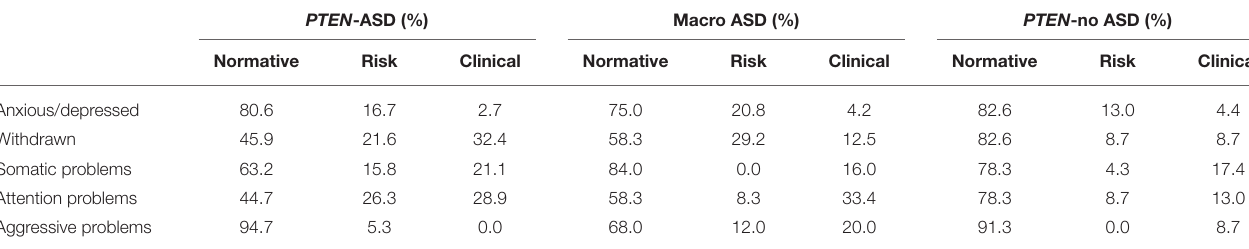
TABLE 3 | Comparison of CBCL and ABC score severity across PTEN -ASD, Macro ASD and PTEN -no ASD groups.